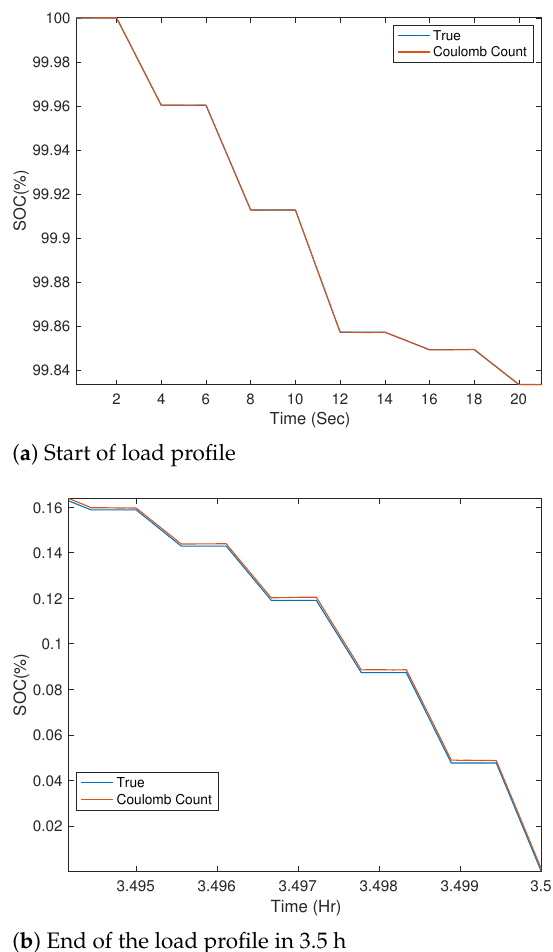
Figure 5. Effect of current measurement error in SOC. ( a ) At the start of the experiment, the true SOC and the computed SOC through Coulomb counting are nearly identical. ( b ) Within 3.5 h, the true SOC and the computed SOC are slightly different. Simulation Parameters: current measurement error s.d. σ i = 10 mA and sampling time ∆ = 200